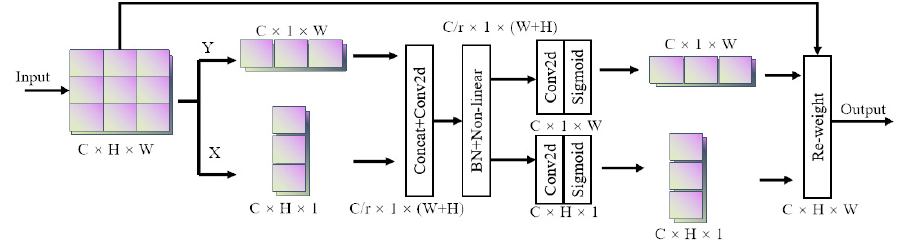
Figure 7. The schematic diagram of